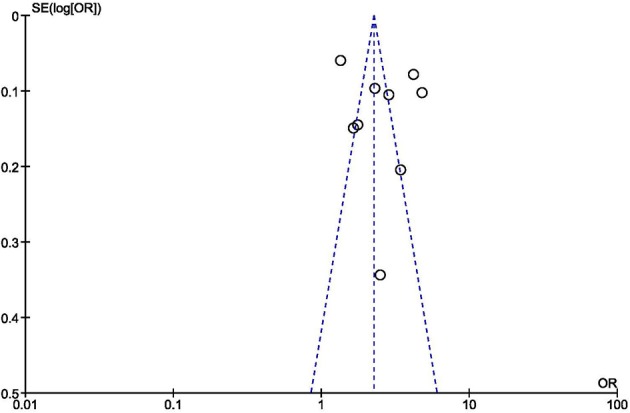
Meta-analysis of the association of workplace violence and sleep problems. Funnel plot.